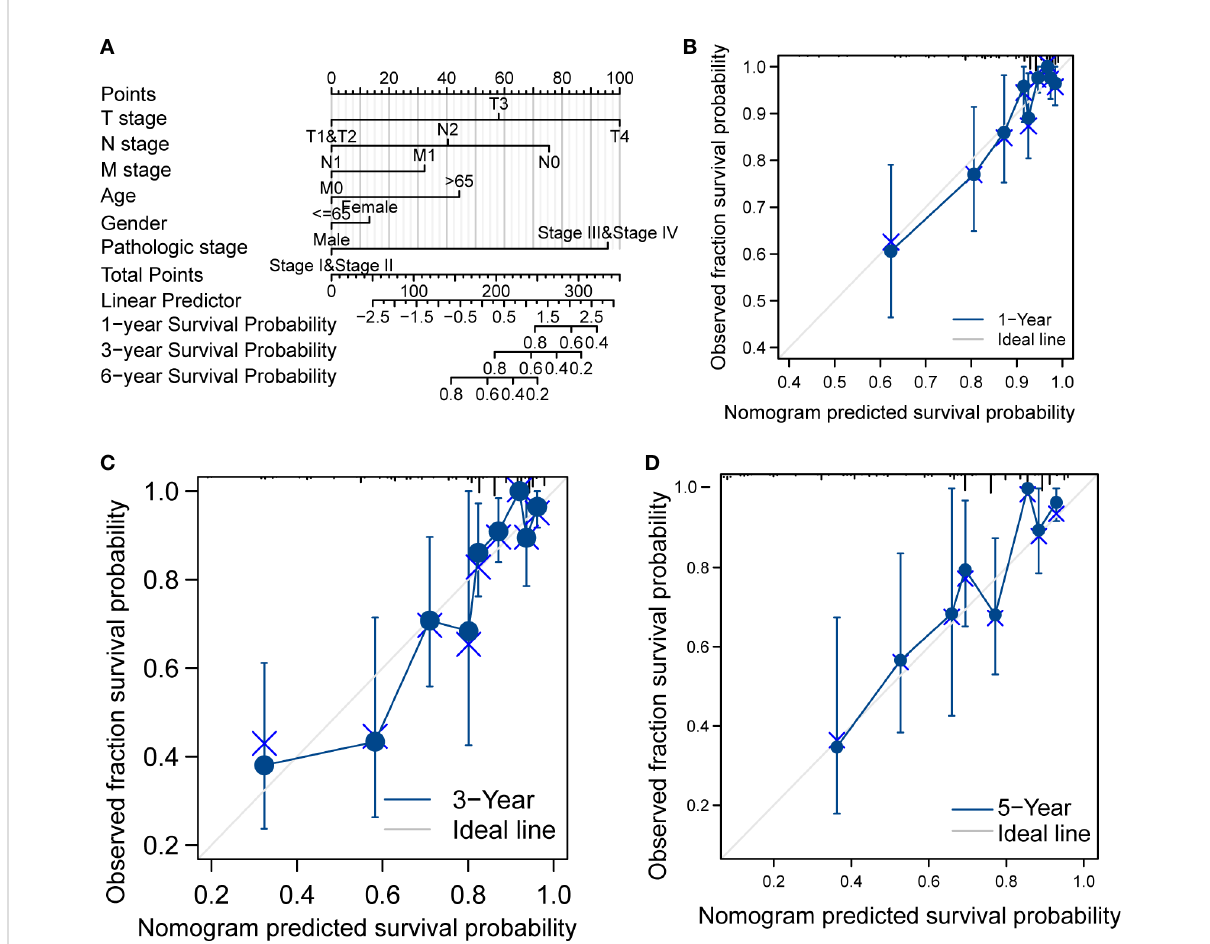
FIGURE 5 Prognostic analysis of CRC. (A) Nomogram of the prognostic model in the entire TCGA dataset. (B) Calibration of the 1-year prognostic model in the entire TCGA set. (C) Calibration of the 3-year prognostic model in the entire TCGA set. (D) Calibration of the 6-year survival in the entire TCGA